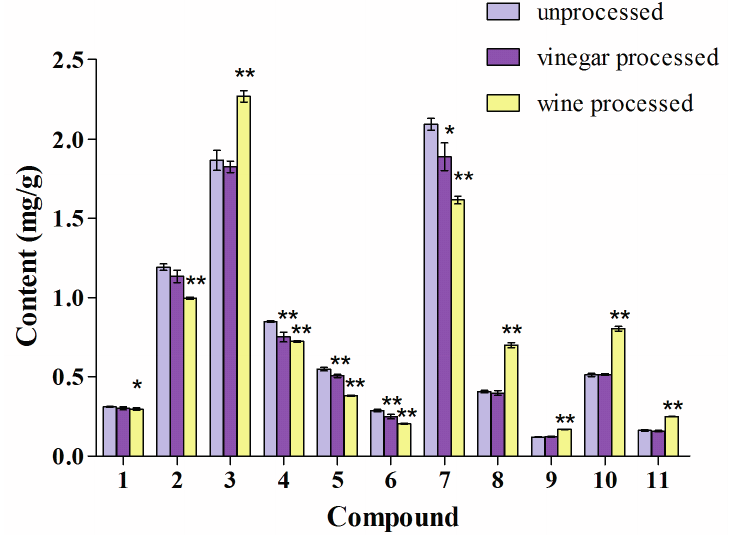
Figure 4. Alkaloid content of the methanol extract of Corydalis Rhizoma. Values are mean ± SD, n = 3, RSD < 4%. ** p < 0.01, * p < 0.05 of processed against unprocessed Corydalis